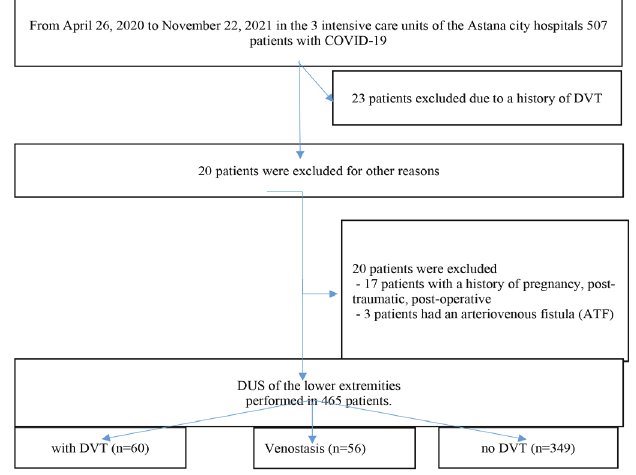
Figure 1 - Selection of patients for study. DVT - deep vein thrombosis; DUS- Doppler